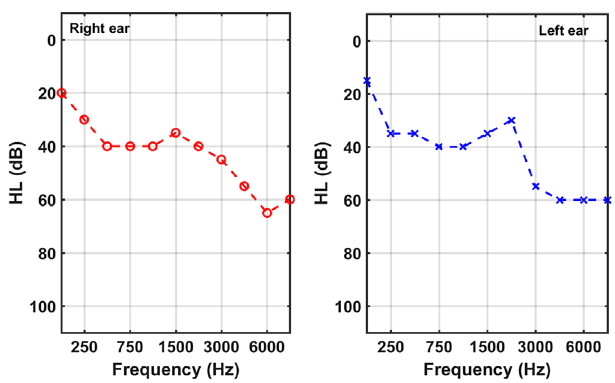
Figure 13. Right and left pure tone audiograms of a partici- pant #3.